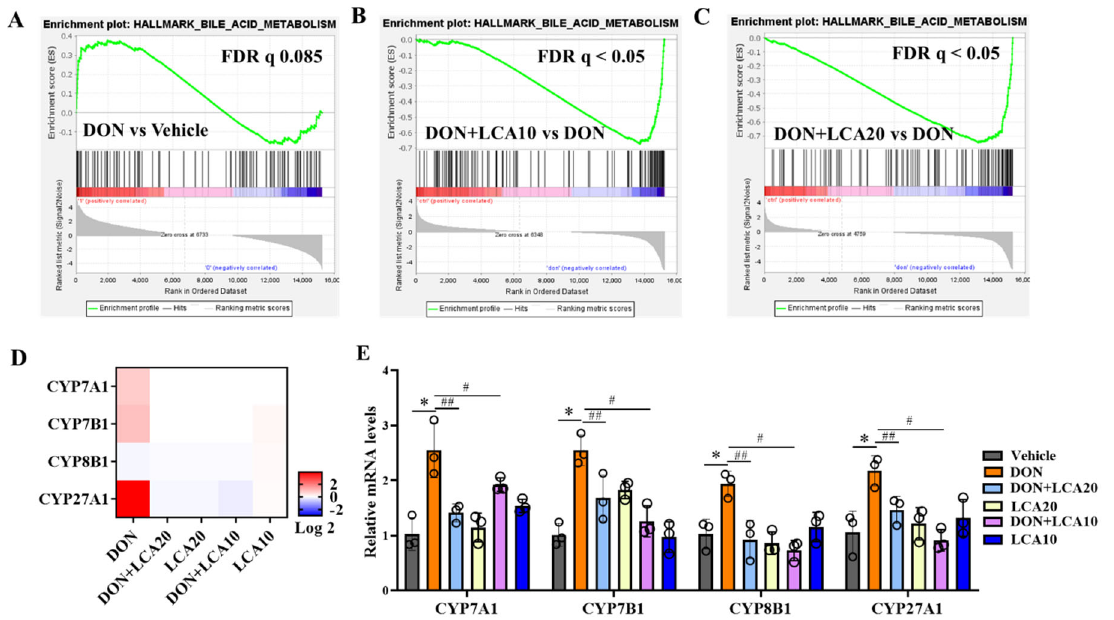
Figure 5. LCA reprograms DON ‐ caused abnormal transcripts of cholesterol transformation. ( A – C ) GSEA analysis of metabolic pathway of cholesterol transformation with indicated treatments. ( D ) Gene transcripts profile of transcriptome analysis. ( E ) qRT ‐ PCR analysis of the gene expression of CYP7A1, CYP7B1, CYP8B1, and CYP27A1. FDR, false–discovery rate. Results are mean ± SD. n = 3. * represents DON group vs. vehicle group p < 0.05. # represents DON + LCA10 group vs. DON group p < 0.05. ## represents DON + LCA20 group vs. DON group p < 0.05.